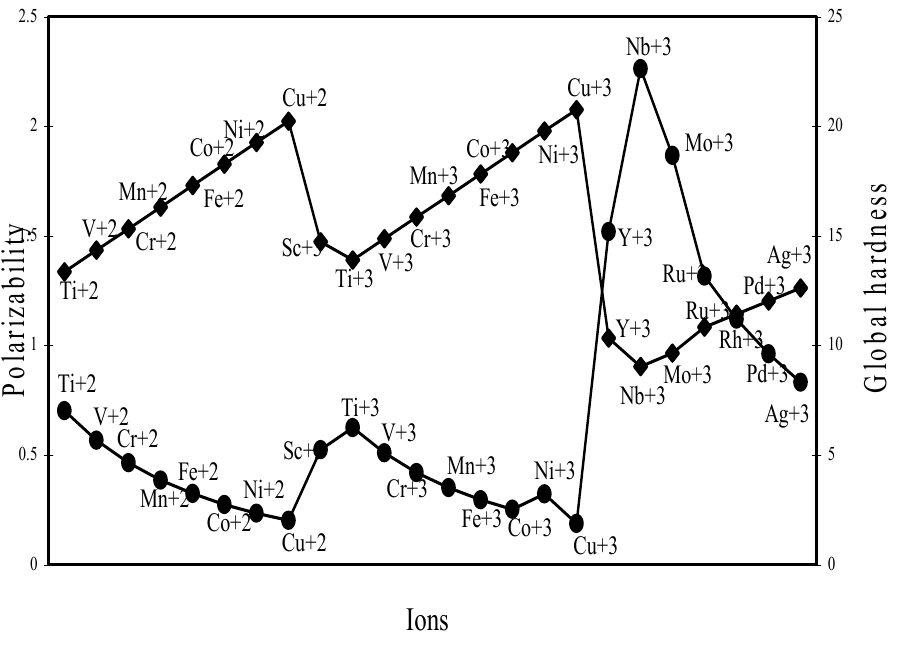
Figure 27. Plot of polarizability and global hardness of some common ions of 1st (3d) and 2nd (4d) transition series